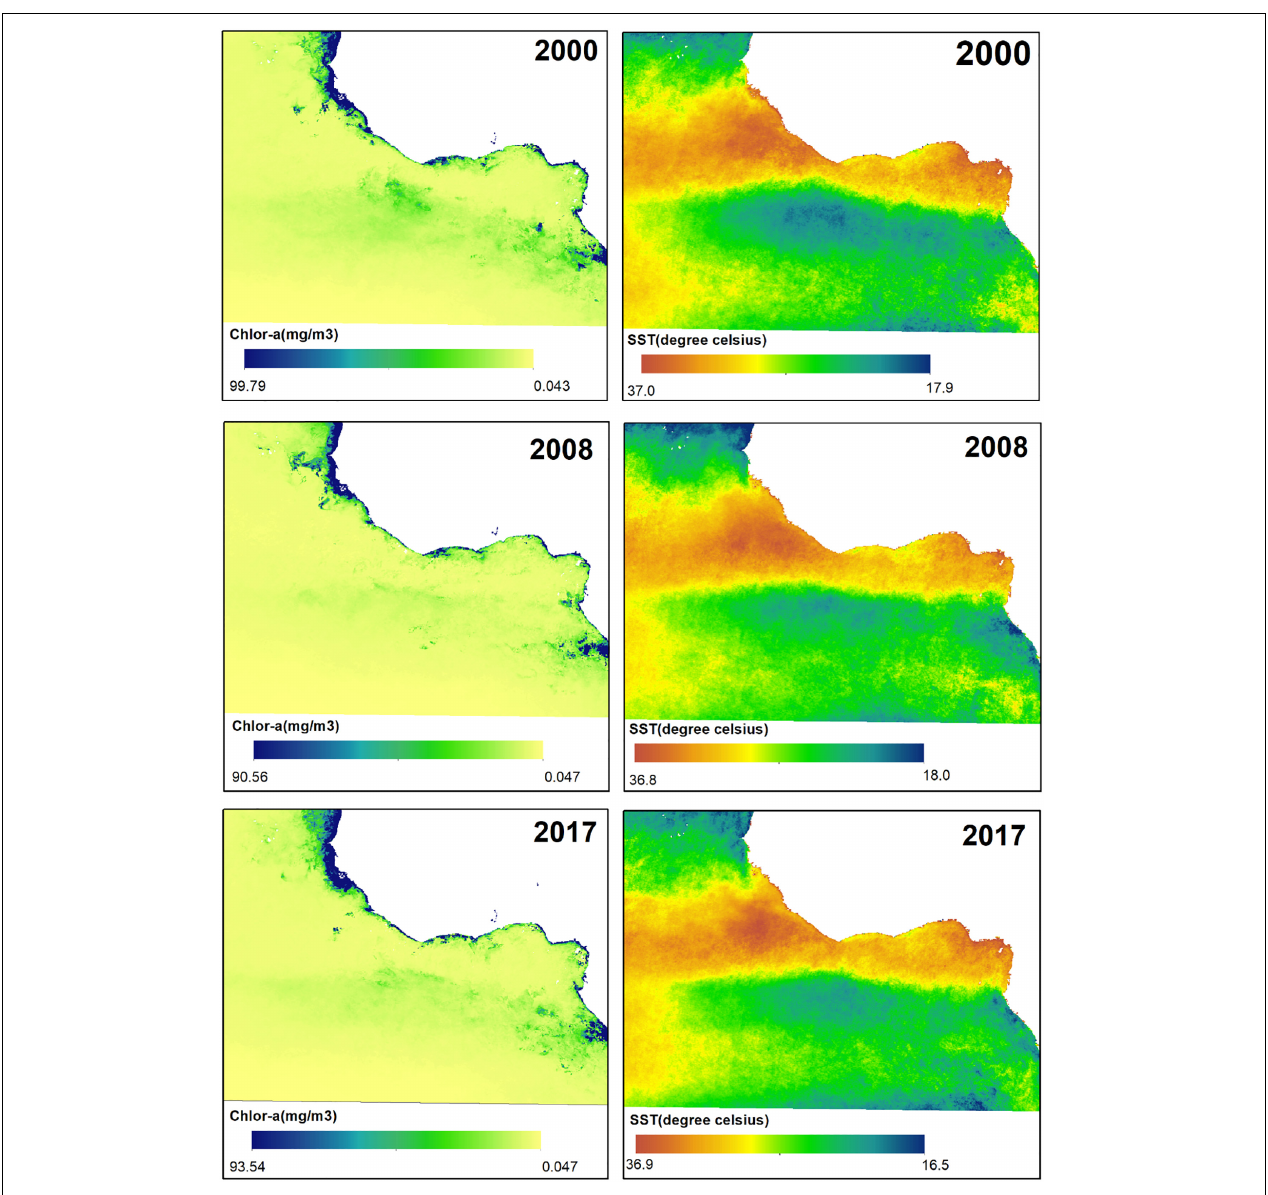
FIGURE 12 | Variations of Chl a and SST from 2000 to